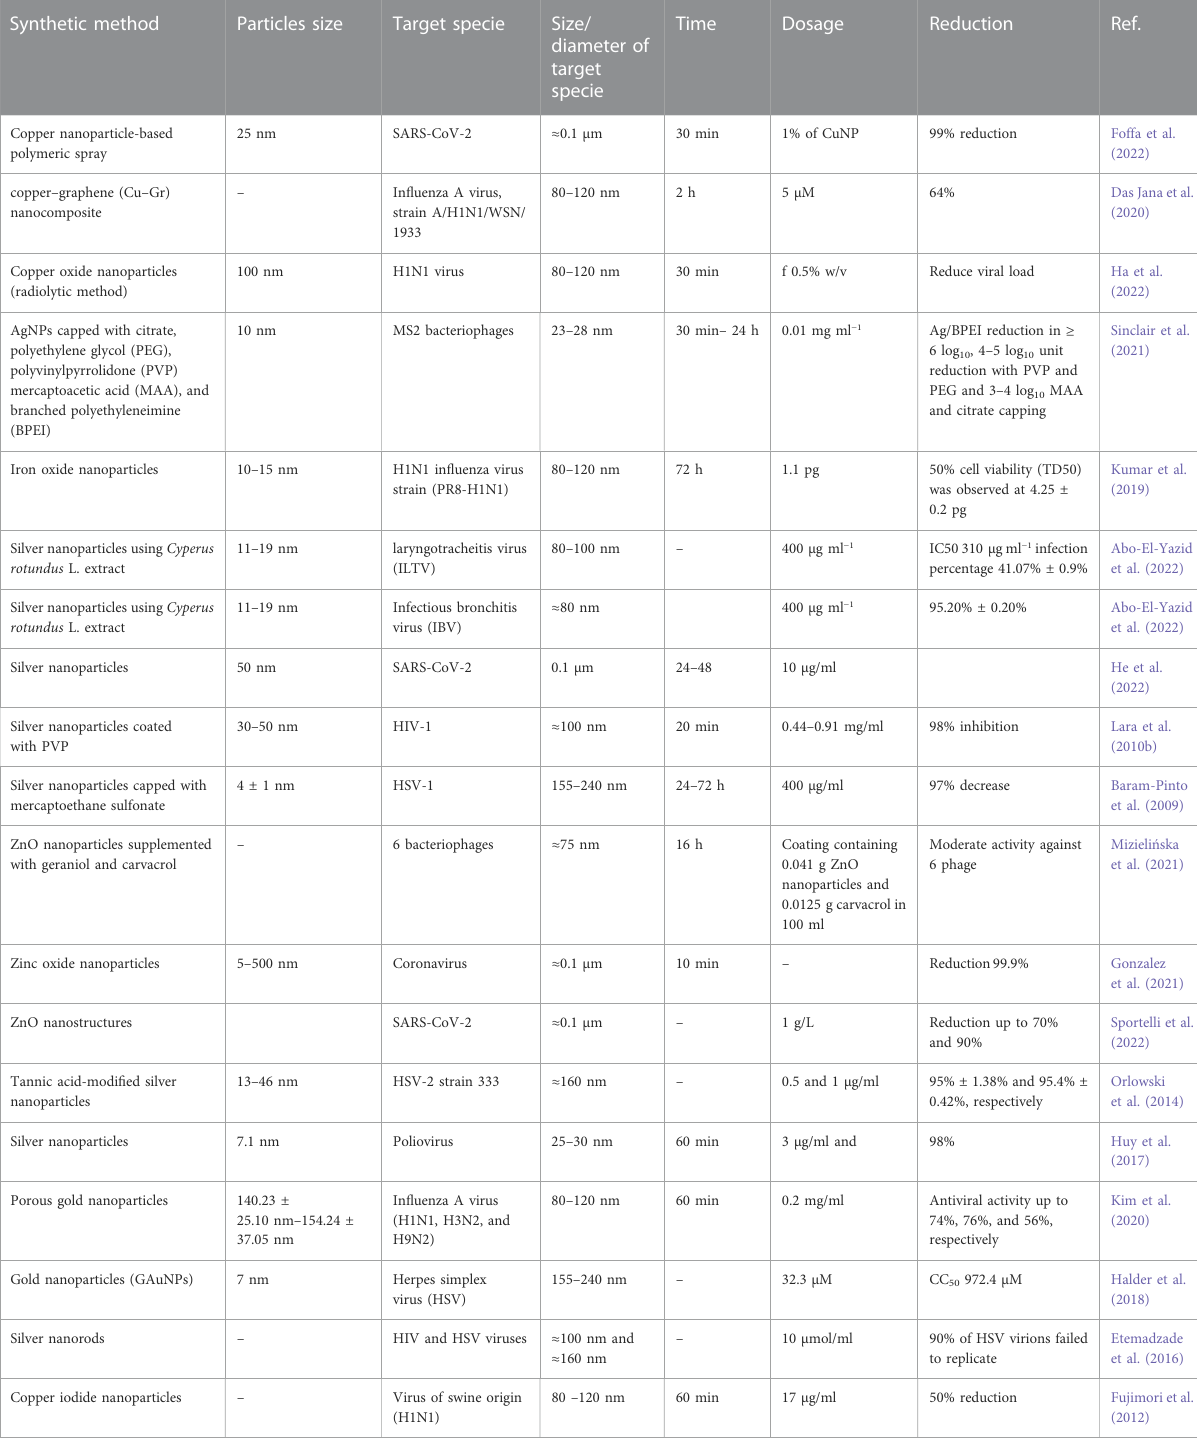
TABLE 1 Applications of various metallic nanoparticles in the deactivation of